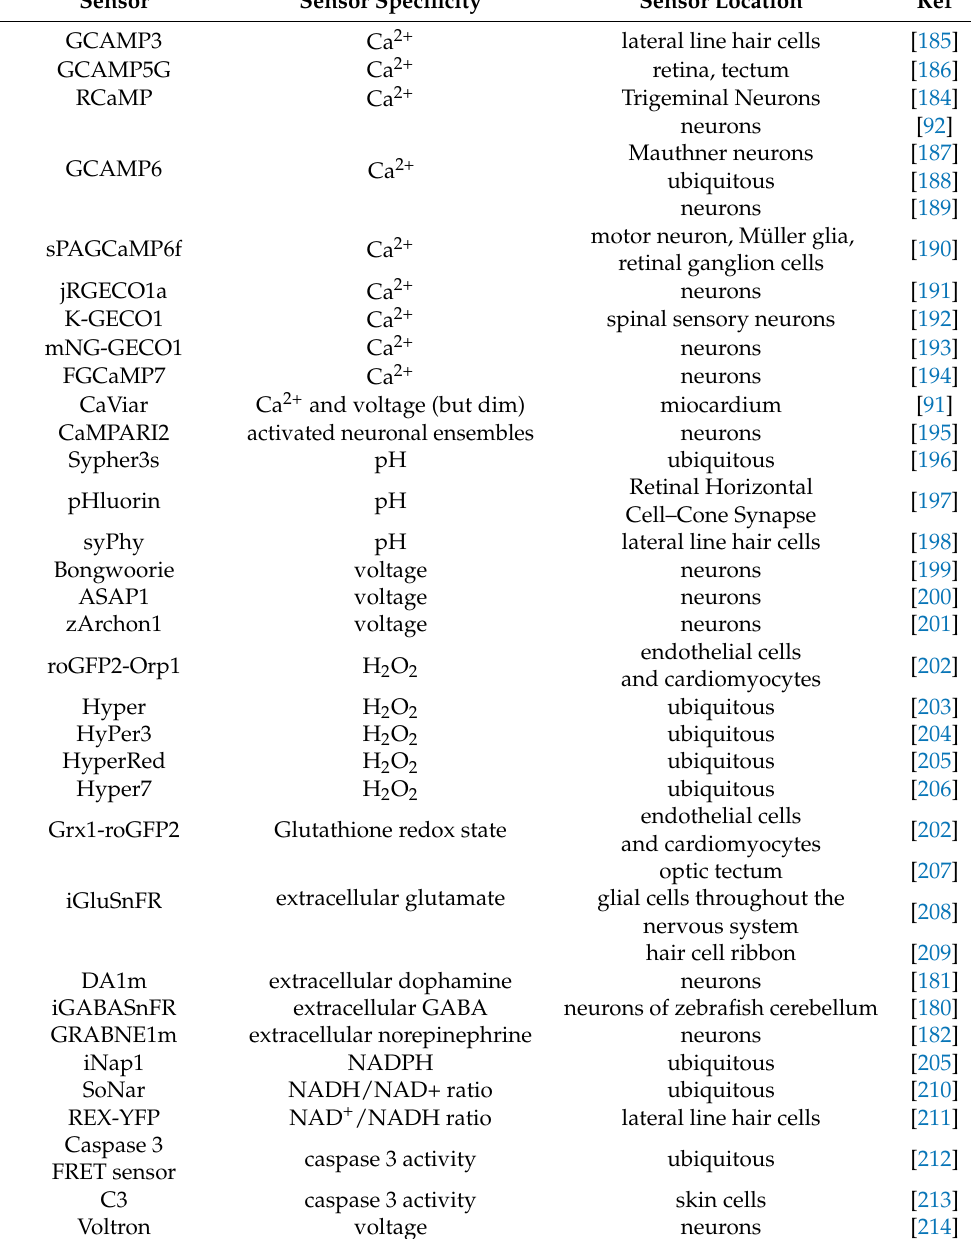
Table 1. Fluorescent sensors successfully tested and applied for basic research in